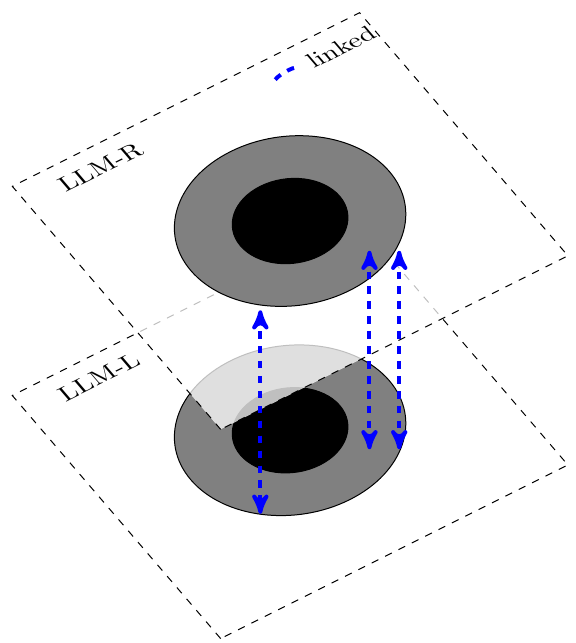
Figure 18 . Schematic representation of the gravity dual for two maximally entangled modi(cid:12)ed superstars. The existence of quantum correlations and entanglement is captured by the gluing of both LLM geometries along the gray